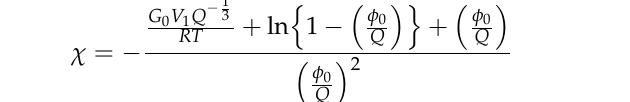
Figure 5. The absolute value of elastic pressure |Π el | (solid lines) and mixing pressure Π mix (dashed lines) of the 10 K (blue), 20 K (red), and 40 K (black) Tetra-PAA-PEG gels as a function of the swelling ratio Q. Figure 6 compares the experimental results of the 10 K, 20 K, and 40 K Tetra-PAA- PEG gels with the predictions made using the FRGDM model under ionic strengths of 2 and 10 mM. As indicated, the FRGDM model predictions reproduce well the swelling behavior of the 40 K Tetra-PAA-PEG gel. However, as Q becomes larger, the downward deviation from the theoretical lines becomes more pronounced, thereby indicating that the original FRGDM model fails to predict Q in the higher swelling regime ( Q > 10).